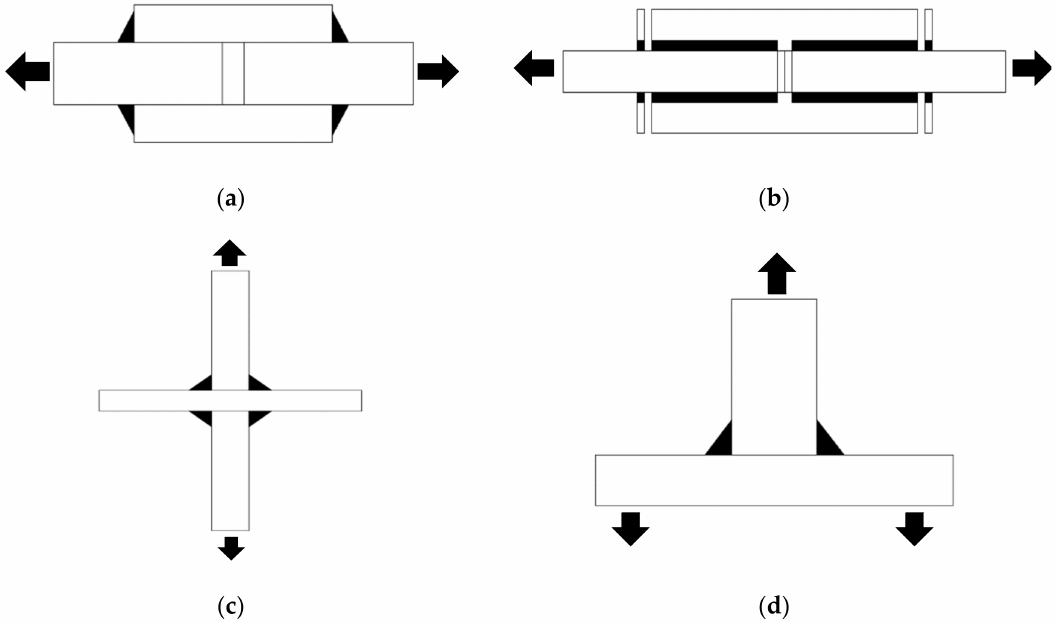
Figure 1. Schematic diagram of fillet welded joints. ( a ) Transverse fillet welded lap joint; ( b ) Longitu- dinal fillet welded lap joint; ( c ) Cruciform joint or X-joint; ( d )